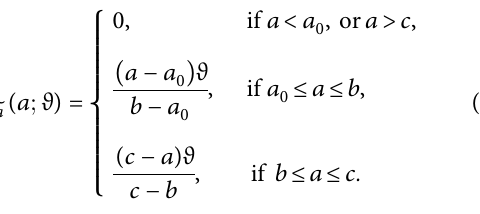
Figure 1: α -Cut of the triangular fuzzy